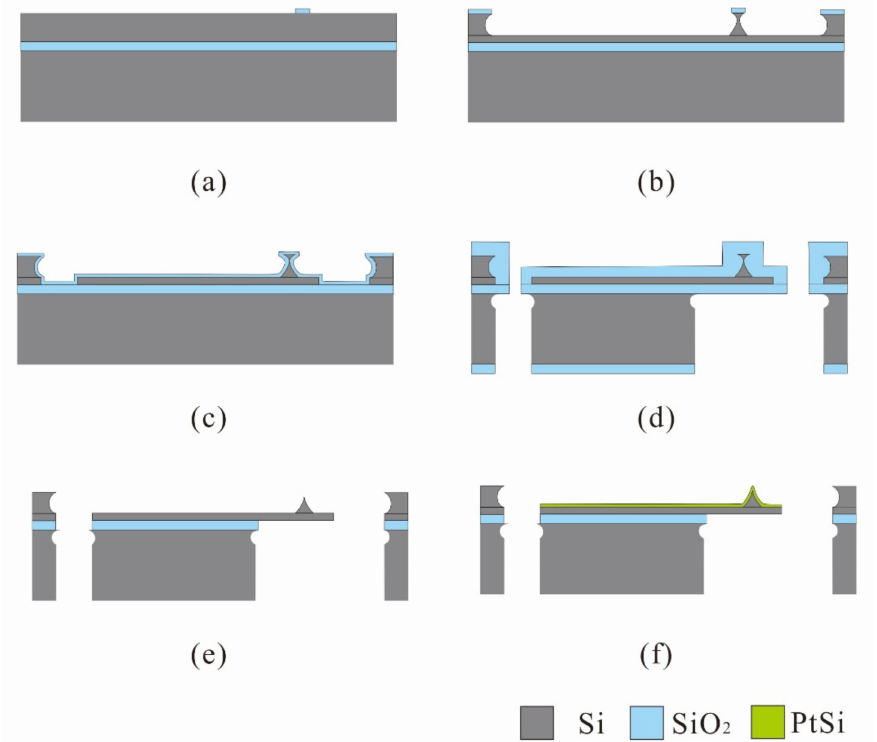
Figure 1. Fabrication process of conductive probes. ( a ) Pattern oxide layer as the mask. ( b ) Isotropic etching of silicon. ( c ) Thermal oxygen sharpening. ( d ) PECVD SiO 2 as mask and define the chip body. ( e ) Removal the oxide layer in BHF. ( f ) Depositing Pt films and annealing.